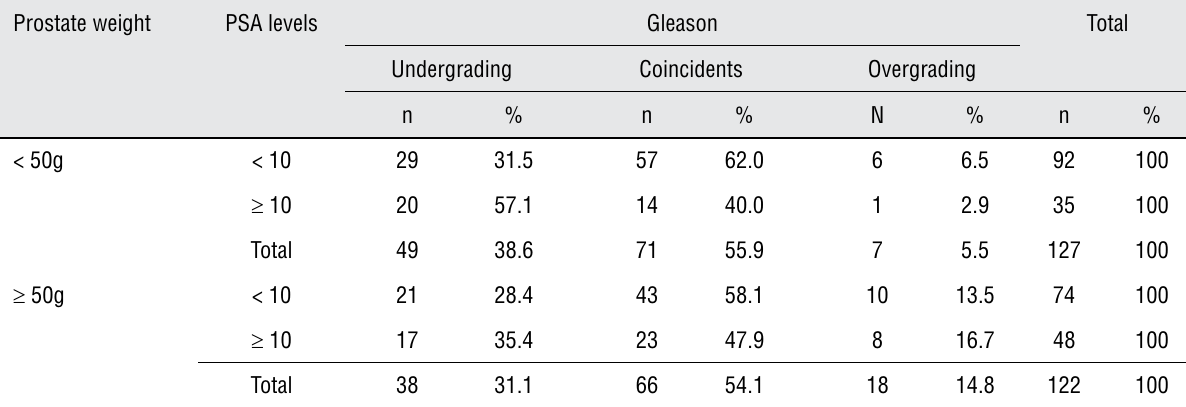
Table 2 - Coincidence and types of discrepancy of GS according prostatic weight. Prostate weight